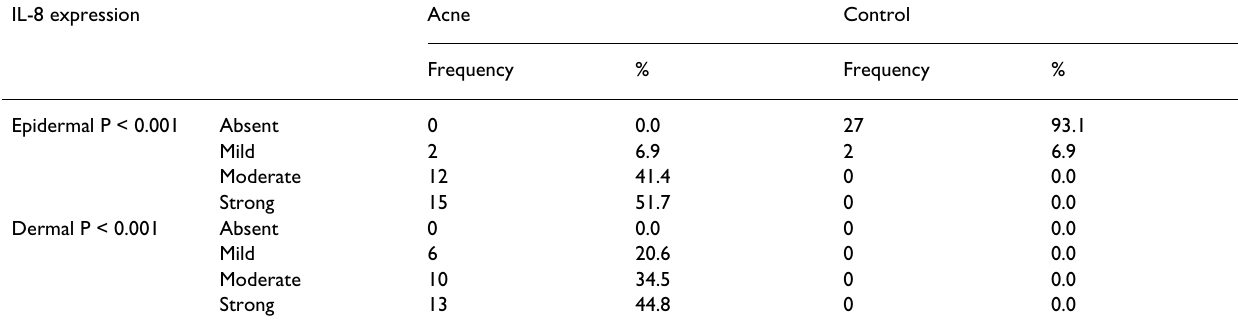
Table 2: IHC expression of IL- 8 in IAV and control groups IL-8 expression Acne Control Frequency % % Epidermal P < 0.001